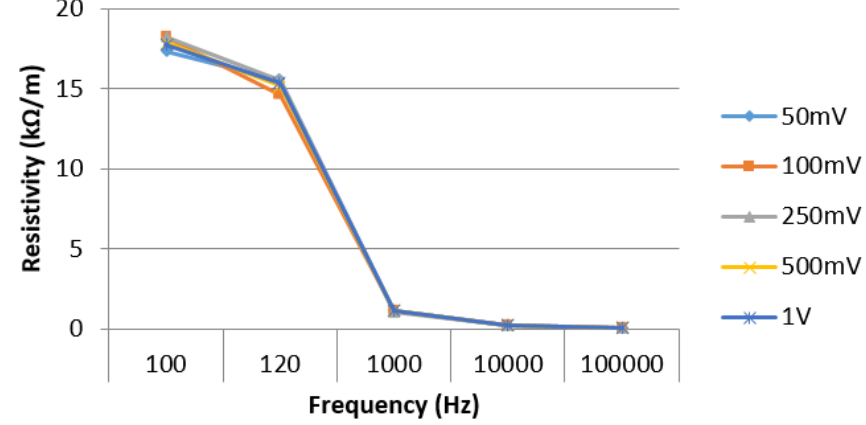
Figure 4. The resistivity of the S-ZnSe crystal at di ff erent biases and frequencies.